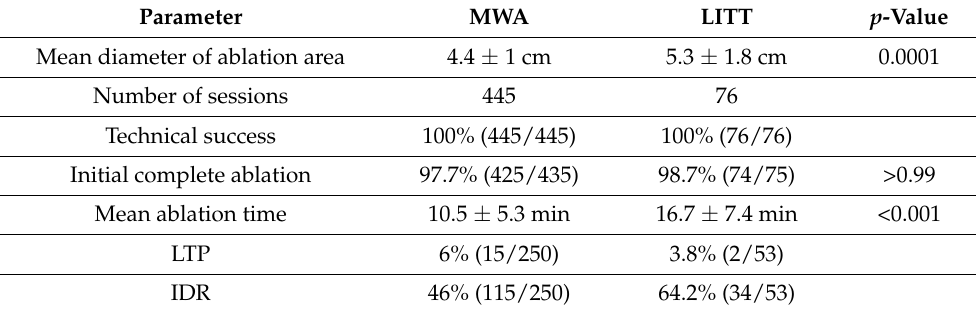
Table 2. Results and